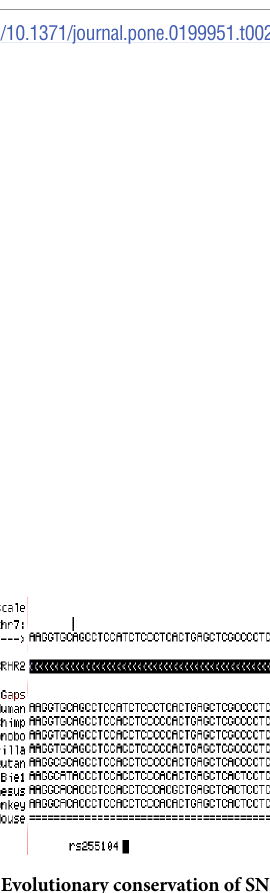
Fig 2. Evolutionary conservation of SNP rs255015 region. The ancestral T allele is highly conserved across representative species.